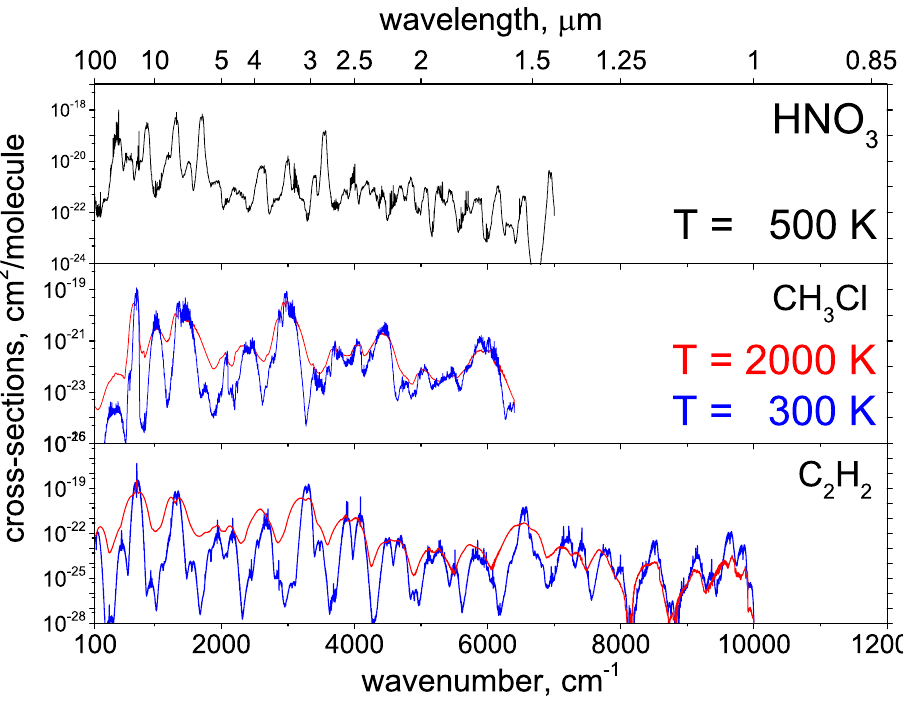
Figure 4. Cross sections obtained from ExoMol line lists for HNO 3 [60], CH 3 Cl [75], and C 2 H 2 [90]. C 2 H 2 : acetylene cross sections given in Figure 4 are generated using the ASD-1000 database [90]. ASD-1000 was generated using an Effective Hamiltonian and contains about 34,000,000 lines. This would appear to be too few lines for the line list to be complete at elevated temperatures as normally, hot line